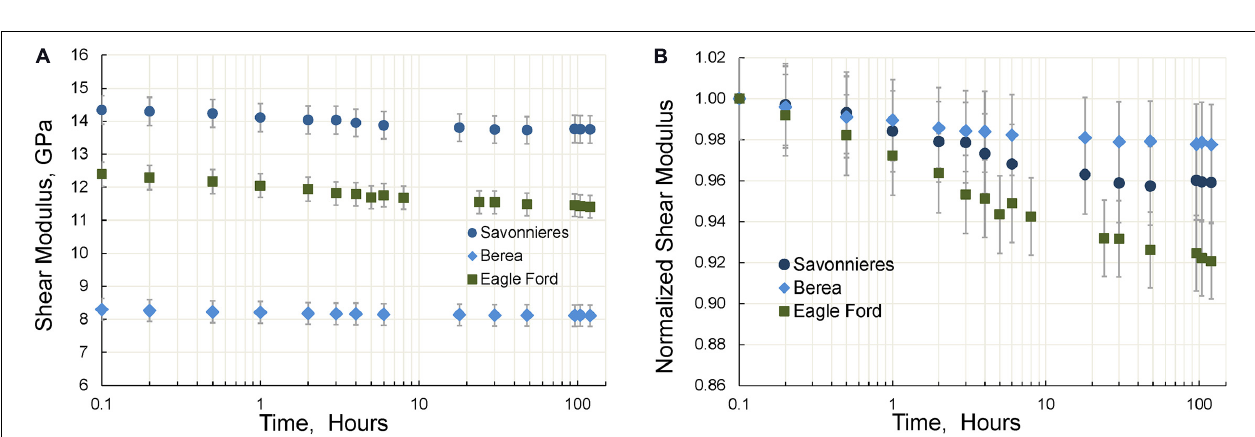
FIGURE 8 | The time dependencies of the shear (A) and normalized shear (B) moduli of three tested samples. The measurements are conducted at a uniaxial pressure of 10 MPa.